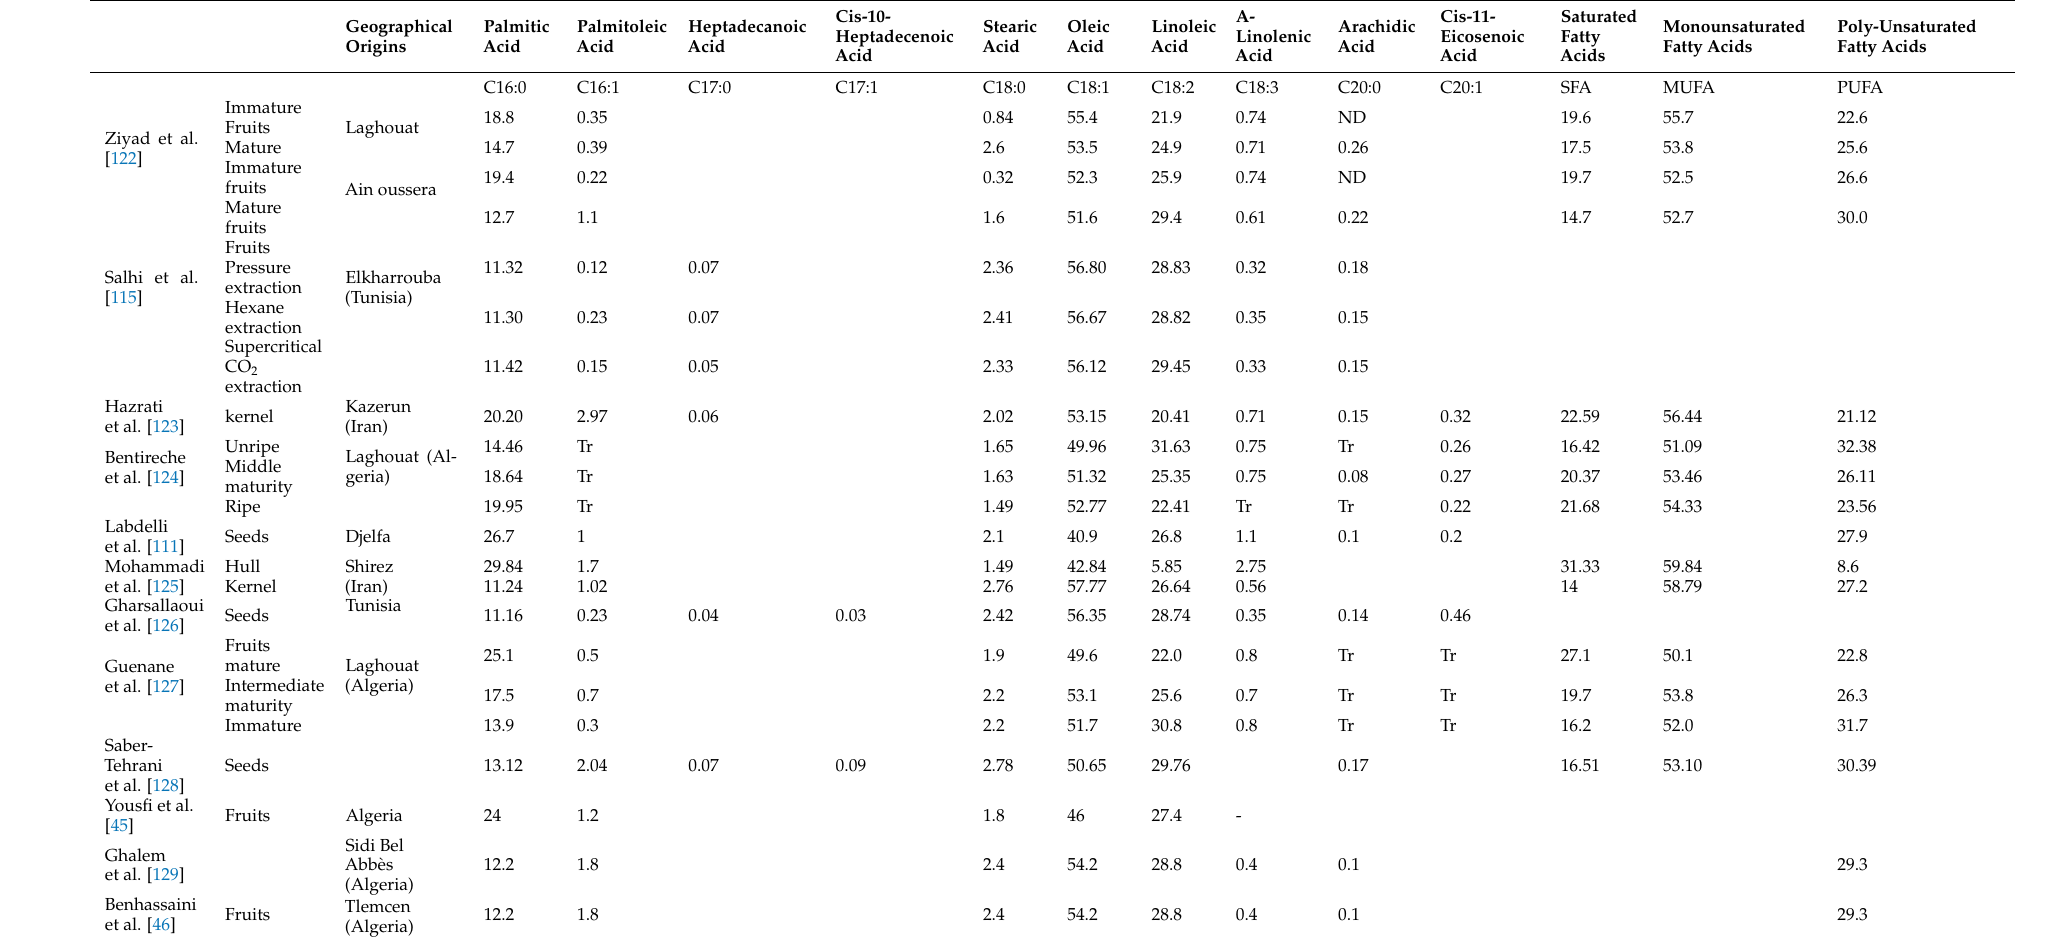
Table 2. Fatty acids composition of P. atlantica samples obtained by CG